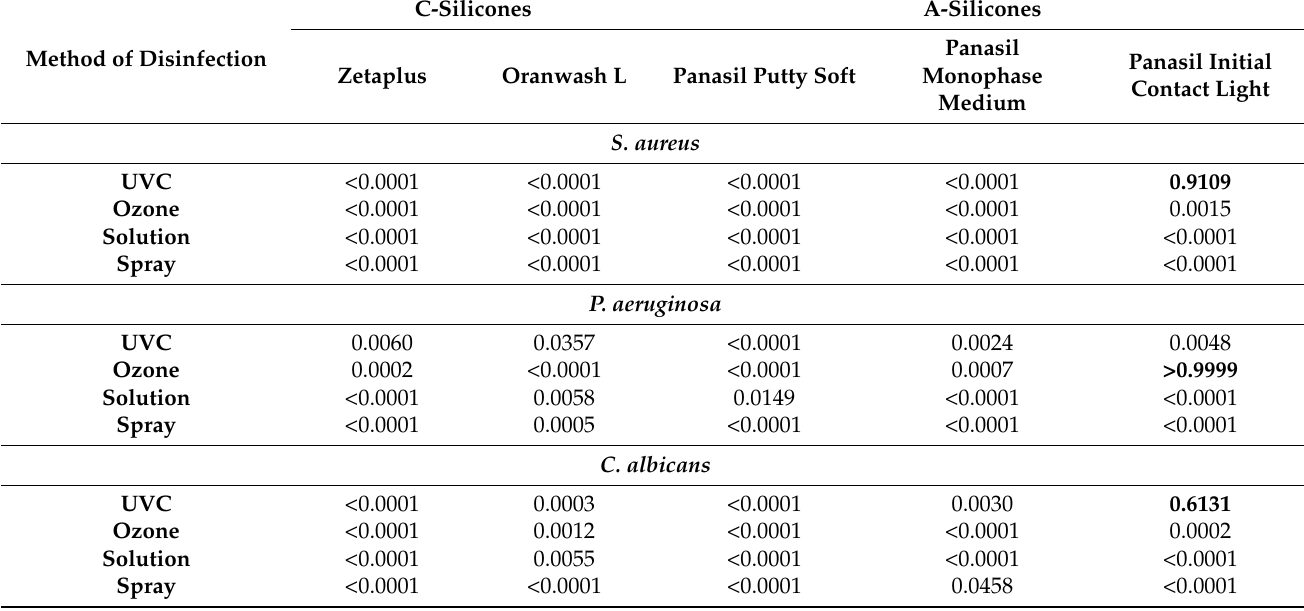
Table 3. Summary of the results of statistical analysis comparing the efficacy of different methods of disinfection of C-silicones and A-silicones; the table presents p -values from multiple comparisons test used to compare microbial growth after disinfection to the non-disinfected control; bolded p -values (>0.05) are considered non-significant, indicating lack of efficacy of the proposed method of